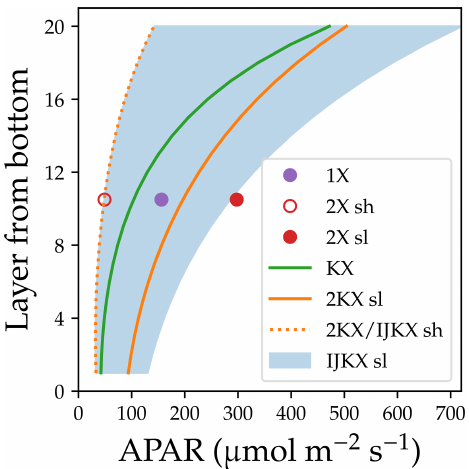
Figure 3. Comparison of profiles of mean absorbed photosyn- thetically active radiation (APAR) for four different canopy com- plexity levels. 1X: single-layer canopy without sunlit or shaded fractions. 2X: single-layer canopy with sunlit and shaded frac- tions. KX: multiple-layer canopy without sunlit or shaded fractions. 2KX: multiple-layer canopy with sunlit and shaded fractions per layer. IJKX: multiple-layer canopy with sunlit and shade fractions per layer, with the sunlit fraction being further partitioned based on leaf inclination and azimuth angular distributions. The abbrevia- tions “sl” and “sh” stand for sunlit and shaded leaves,